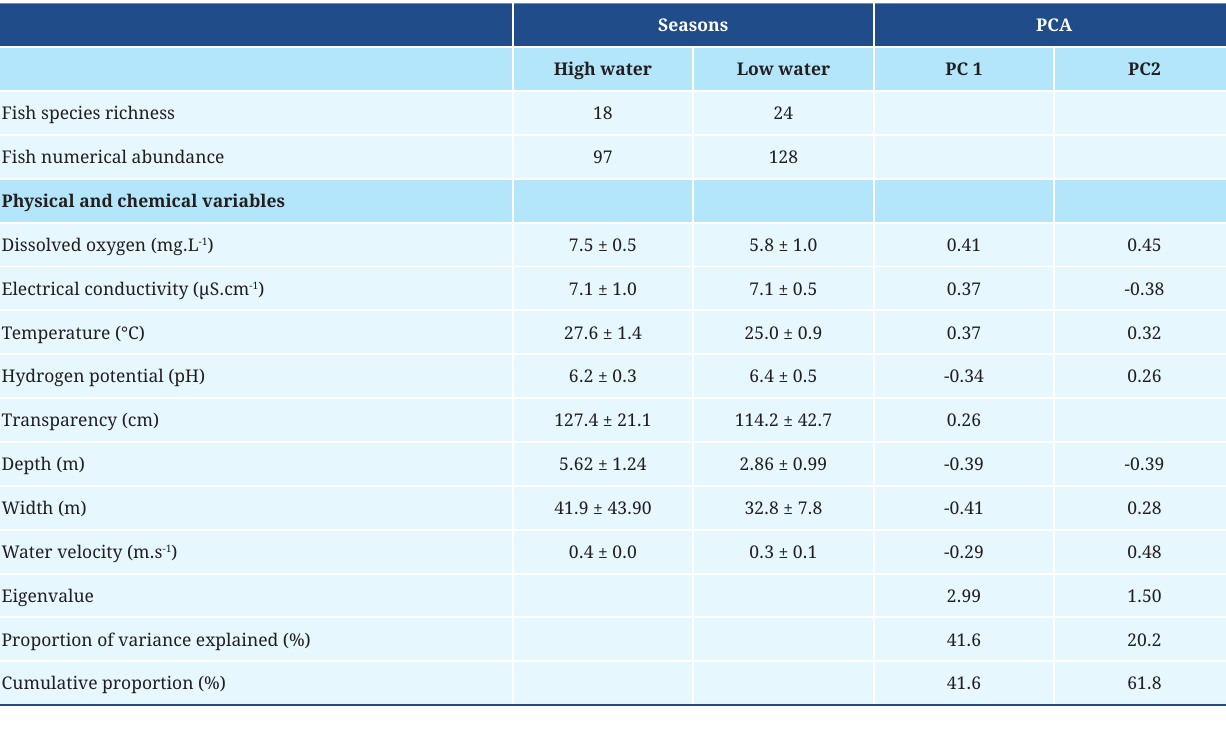
TABLE 1 | Descriptors of the fish assemblages, environmental variables (mean ± SD), and scores on the first two axes of the principal components (PCA) in the high water and low water seasons of the Tarumã River.